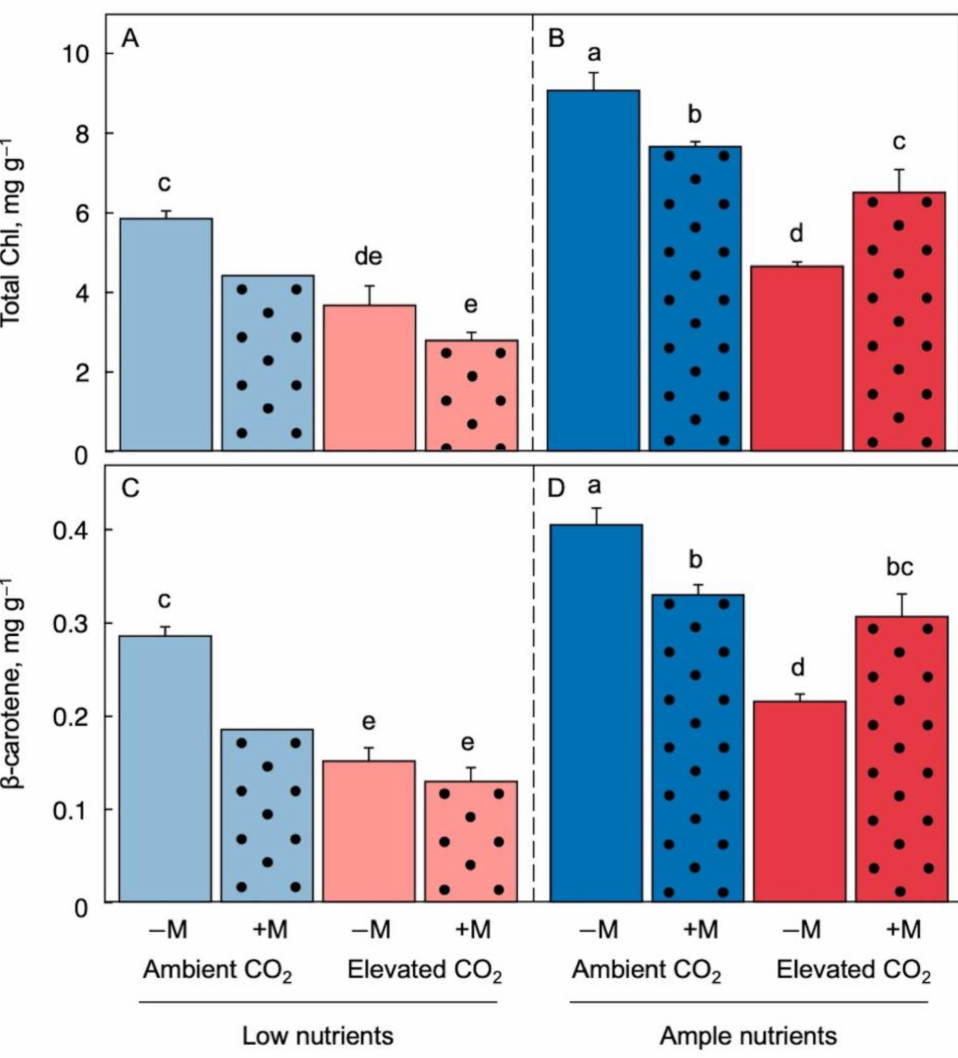
Figure 4. Total chlorophyll ( a + b ) content under low ( A ) and ample ( B ) nutrients as well as β -carotene to biomass ratio under low ( C ) and ample ( D ) nutrients for Lemna minor grown in 1/20 (light blue or light red) or 1/2 strength (dark blue or red) Schenk & Hildebrandt medium and either ambient (blue) or elevated (red) CO 2 levels. Bars with solid fill represent groups that were not inoculated ( − M), compared to bars with dotted fill that were inoculated (+M). Mean values ± standard deviations; n = 3 under all conditions except for n = 2 in the treatment of inoculated fronds in ambient CO 2 and low nutrients. Different lower-case letters represent significant differences at p <